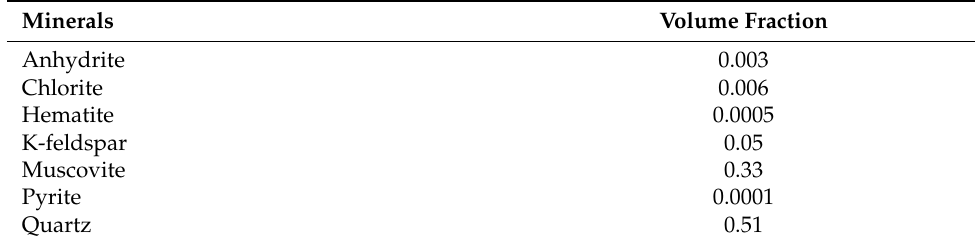
Table 4. Initial mineral volume fractions of the basement unit.